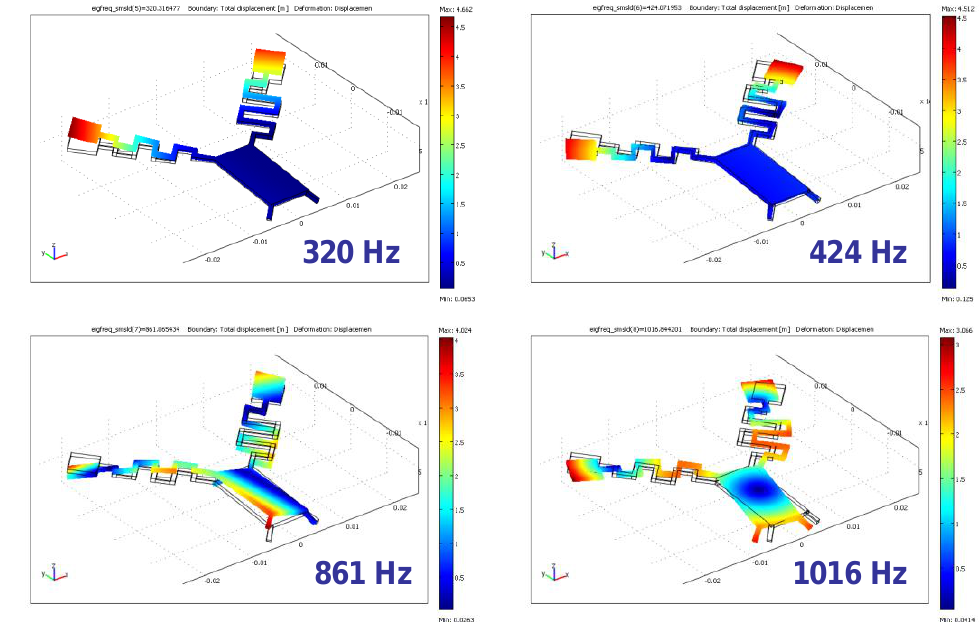
Figure 4. Eigenmodes as simulated in COMSOL for the